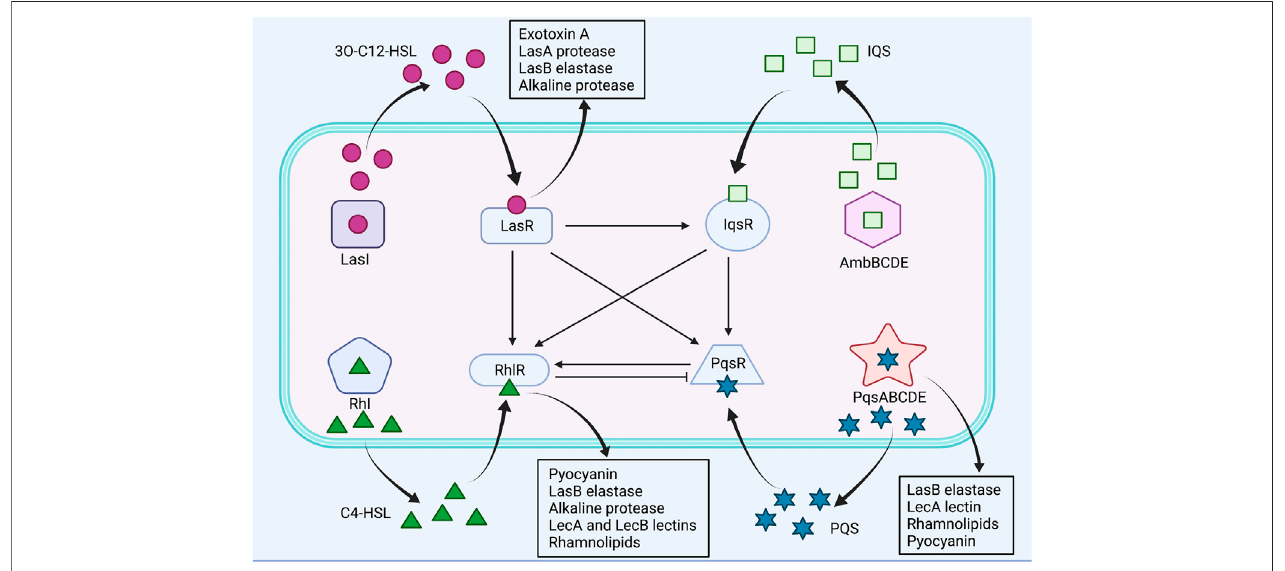
FIGURE2| TheQSsystemsof P.aeruginosa andtheirinteractions. Pseudomonasaeruginosa utilizesfourQSsystems,includingLasI/LasR,RhlI/RhlR,PQS/MvfR andIQSsystems.LassystempositivelyregulatesRhl,PQSandIQSsystems.RhlsystemnegativelyregulatesPQSsystem,whereasPQSsystempositivelyregulatesRhl system. IQS system positively regulates Rhl and PQS systems. Positive control is represented by arrows, and negative control is represented by blunted arrows.